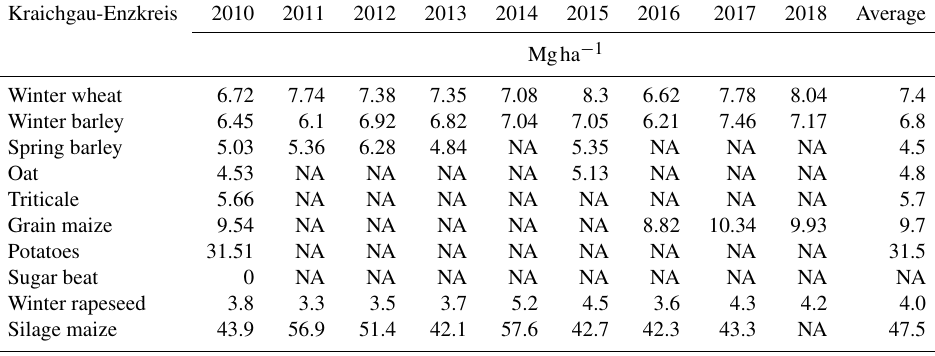
Table B1. Average yields of the Kraichgau district Enzkreis for the years 2010–2018. Values that are not available are indicated by NA. Data from the Statistisches Landesamt Baden-Württemberg accessible at https://www.statistik-bw.de/SRDB/ (last access: 20 May 2020): Regionaldaten – Land- und Forstwirtschaft – Ernte – Hektarerträge der Feldfrüchte (Landkreis Enzkreis).